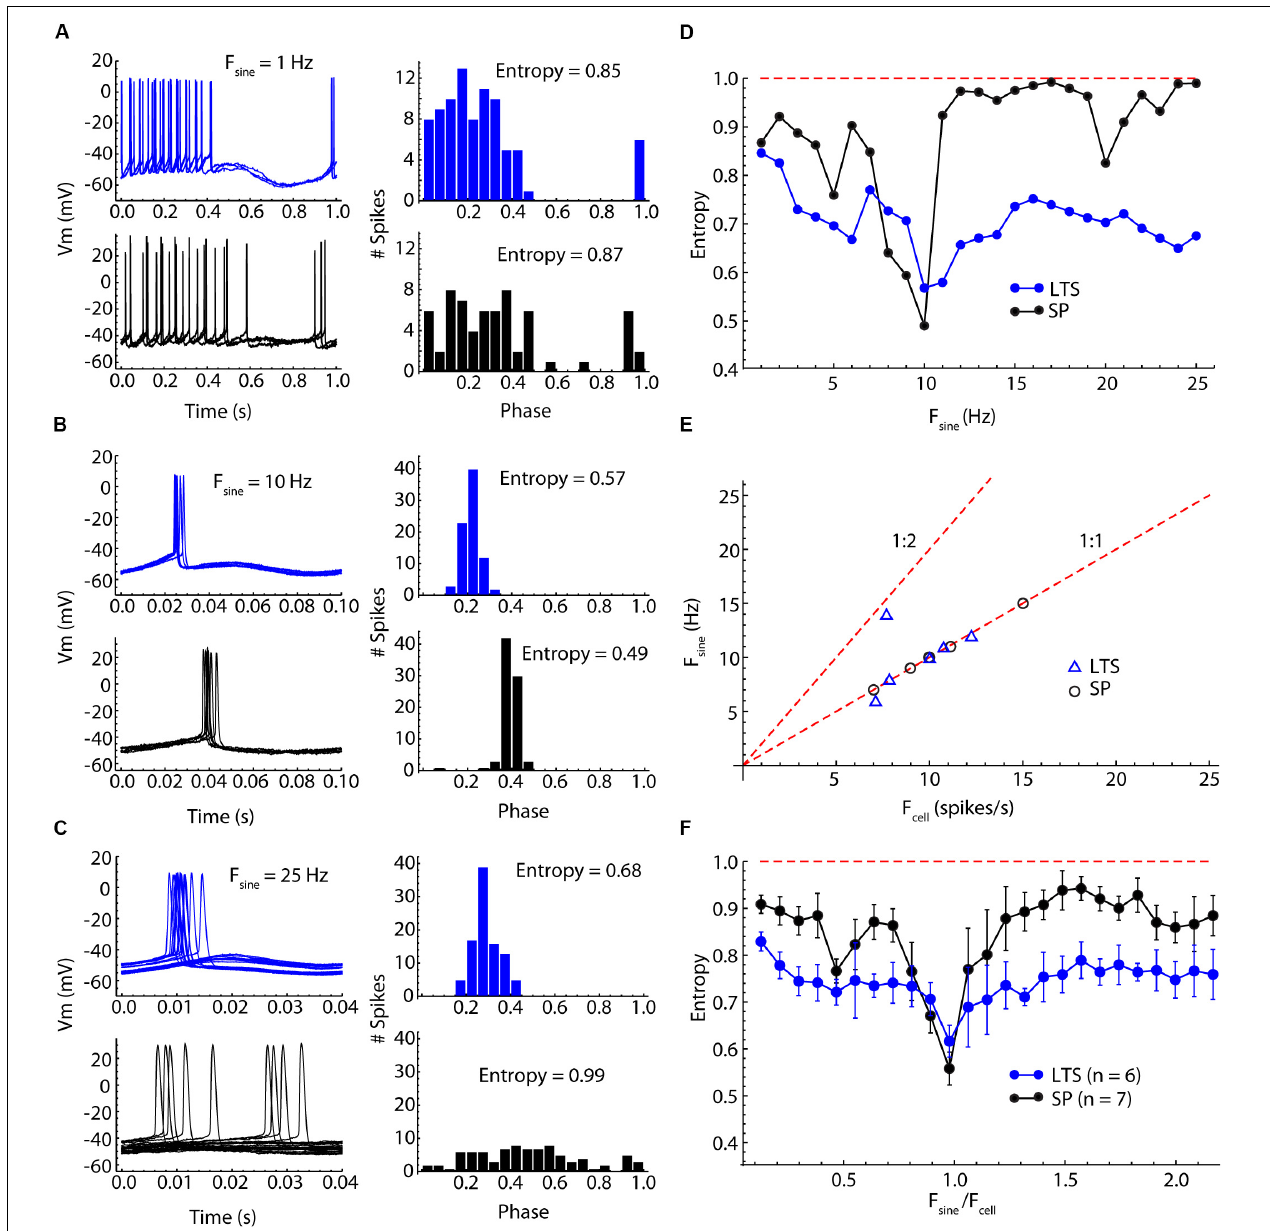
FIGURE 5 | Comparison of SP neuron and LTS interneuron entrainment by injected sinusoidal currents of frequencies between 1 and 25 Hz. (A) Low-frequency (1 Hz) sine wave stimulation produced firing rate modulation in both cell types, with neurons firing throughout the positive phase of the stimulus but with little spike time reliability. Example traces for one cycle of the stimulus are shown on the left, and a histogram of spike phases on the stimulus is shown on the right. The peak of the sine wave is phase 0.25, and the trough is phase 0.75. The degree of entrainment is measured as the entropy of the histogram, with low entropies meaning better entrainment. (B) Sinusoidal current waveforms at a frequency near the cells’ unperturbed firing rates (about 10 Hz in both cells) evoke 1:1 entrainment of firing at a reliable phase of the stimulus in both cell types. (C) At frequencies higher than the cell’s firing rate, 1:1 entrainment failed, but LTS interneurons continued to be more entrained than SP neurons, whose spike times were almost completely unrelated to the stimulus sine wave. (D) Entrainment spectra for the example neurons used in (A–C) . Entrainment was better in the LTS interneuron at all frequencies except for those close to the cells’ unperturbed firing rates. The difference is especially clear at frequencies near 1.5 times the unperturbed firing rates, at which the SP neurons showed almost no entrainment. The expected entropy for zero entrainment is indicated by the dotted line. (E) The sine wave frequency producing peak entrainment ( F sine ) was close to the cells’ unperturbed firing rate ( F cell ) in both cell types. One exception is an LTS interneuron that had slightly stronger entrainment at twice the unperturbed firing rate. (F) Mean entrainment profile for a sample of six LTS interneurons and seven SP neurons. F sine is plotted as a proportion of F cell . Note the absence of any second entrainment peak corresponding to the membrane impedance resonance. Compared to SP neurons, LTS neurons are much less frequency-selective, showing substantial entrainment over the entire frequency range.